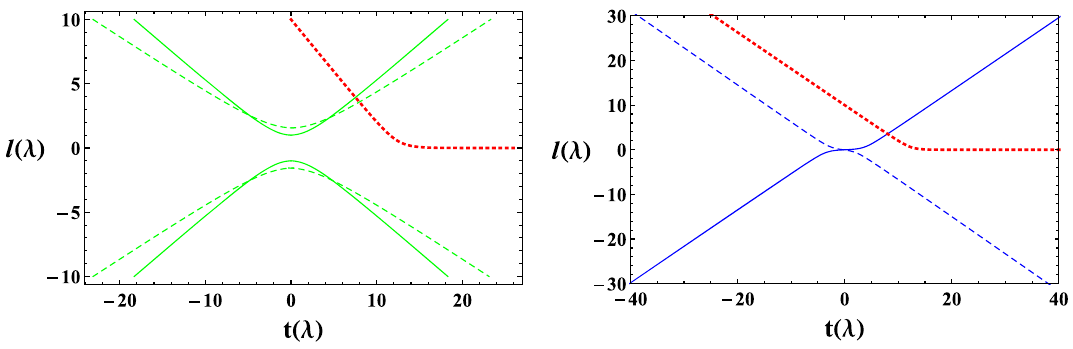
√ √ 3, H = 2, m = 2, b 0 = 1 and the